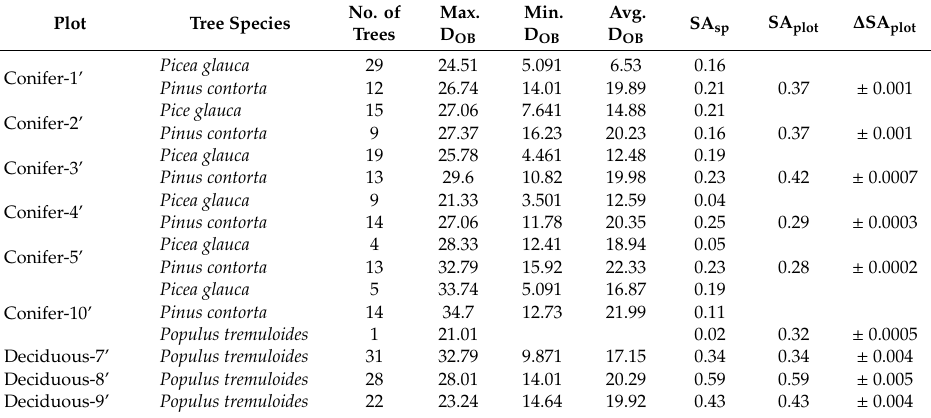
Table 3. Descriptive statistics of the 10 × 10 m stands (indicated with a prime symbol) located in the Sibbald areas of Kananaskis Country, Alberta. Note, ∆ SA plot is the absolute error associated with SA plot . The error propagation estimation is detailed in Section 3.3. D OB units are in cm, and all areas are in units of m 2